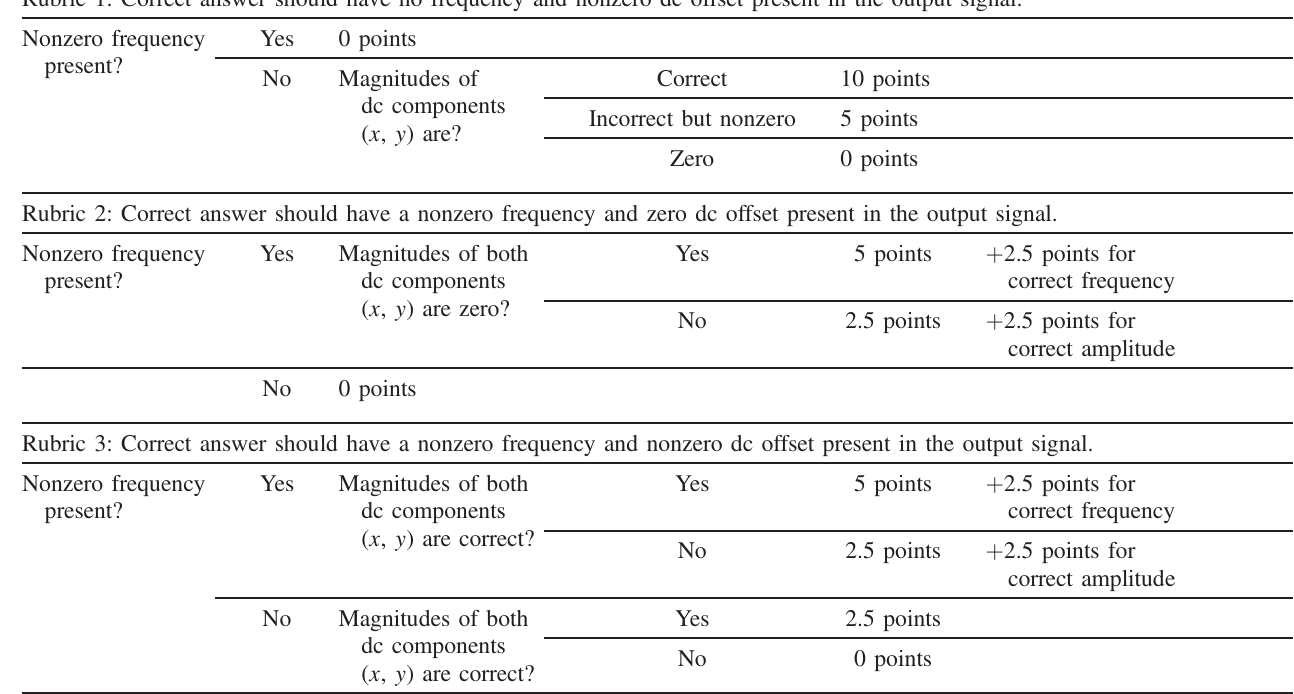
TABLE I. Summary of the grading rubrics used for the pretest and post-test questions discussed. Rubrics 1 through 3 are used to score problems in which the students are asked to sketch the output signal for a given set of input parameters (output problems) and rubrics 4 through 6 are used to score problems in which the students are asked to provide the input parameters for a given output (input problems). Case 1 problems are scored by rubric 1 for output problems and rubric 4 for input problems. Case 2 problems are scored by rubric 2 for output problems and rubric 4 for input problems. Case 3 problems are scored by rubric 1 for output problems and rubric 5 for input problems. Case 4 problems are scored by rubric 3 for output problems and rubric 4 for input problems. Case 5 problems are scored by either rubric 1 or rubric 3 for output problems, depending on the time constant and amplitude modulation frequency given in the problem. There are no case 5 problems in which output is provided and students are asked for input parameters. Case 6 problems are scored by rubric 3 for output problems and rubric 6 for input